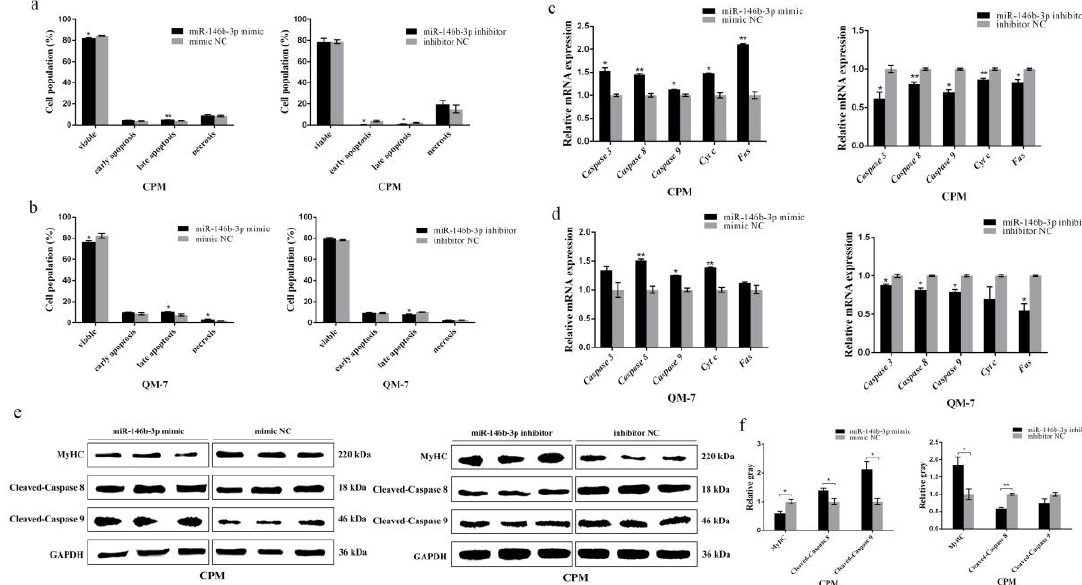
Figure 3. miR-146b-3p promotes myoblast apoptosis. ( a ) Flow cytometry of Annexin V-FITC and propidium iodide (PI) dual staining detecting the apoptosis of CPMs after transfection of miR-146-3p mimic or inhibitor. ( b ) Flow cytometry of Annexin V-FITC and propidium iodide (PI) dual staining detecting the apoptosis of QM-7 cells after transfection of miR-146-3p mimic or inhibitor. ( c ) Relative mRNA expression of the cell apoptosis-related genes after transfection of miR-146-3p mimic or inhibitor in CPMs. ( d ) Relative mRNA expression of the cell apoptosis-related genes after transfection of miR-146-3p mimic or inhibitor in QM-7 cells. ( e ) The protein levels of MyHC, cleaved-caspase 8, and cleaved-caspase 9 after the transfection of mimic or inhibitor in CPMs. ( f ) Gray value analysis of protein bands in ( e ). Results of all groups are shown as mean ± S.E.M. of three independent assessment methods. Statistical significance of the mean difference was assessed using unpaired two-sample t -tests. * p < 0.05; ** p < 0.01. NC, negative control.